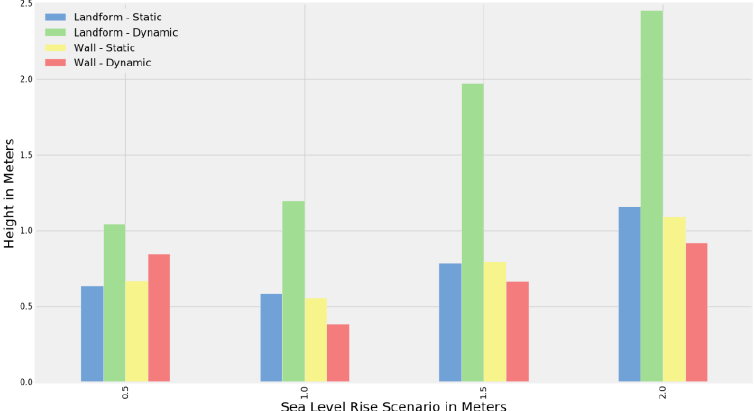
Figure 5. Figure showing the median height of the water that would exceed the top of the four types of protective infrastructure—static landforms, dynamic landforms, static walls, or dynamic walls—with sea level rise scenarios between 0.5 and 2 m.